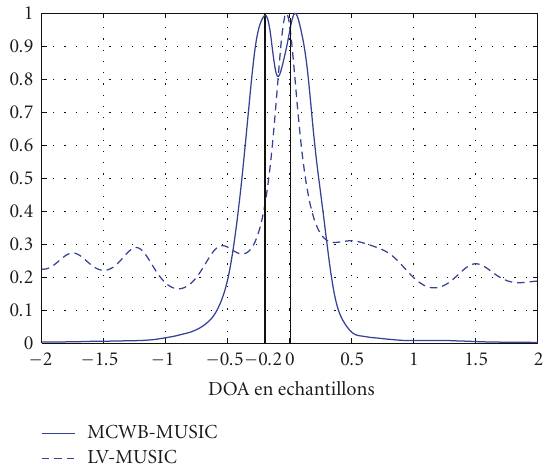
Figure 17: Comparison between MW-MUSIC and LV-MUSIC. Table 2: Estimation of DOAs and o ff sets. DOA (pts.) O ff set